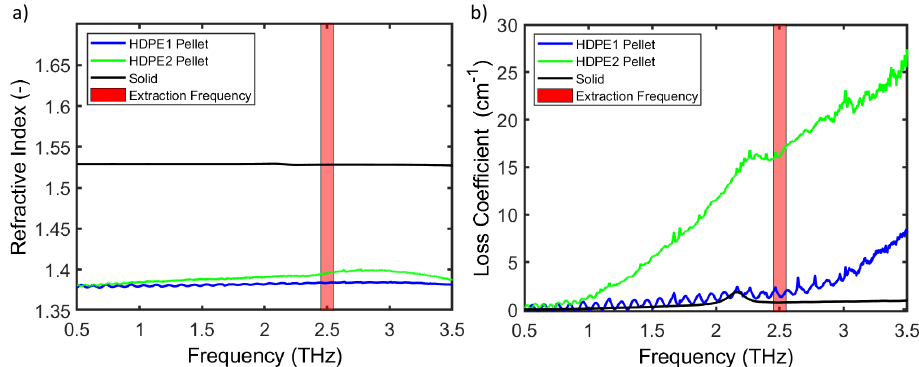
Figure 4. Spectra of HDPE pellets showing the ( a ) refractive index and ( b ) loss coefficient. Oscillations in spectra are artifacts due to internal